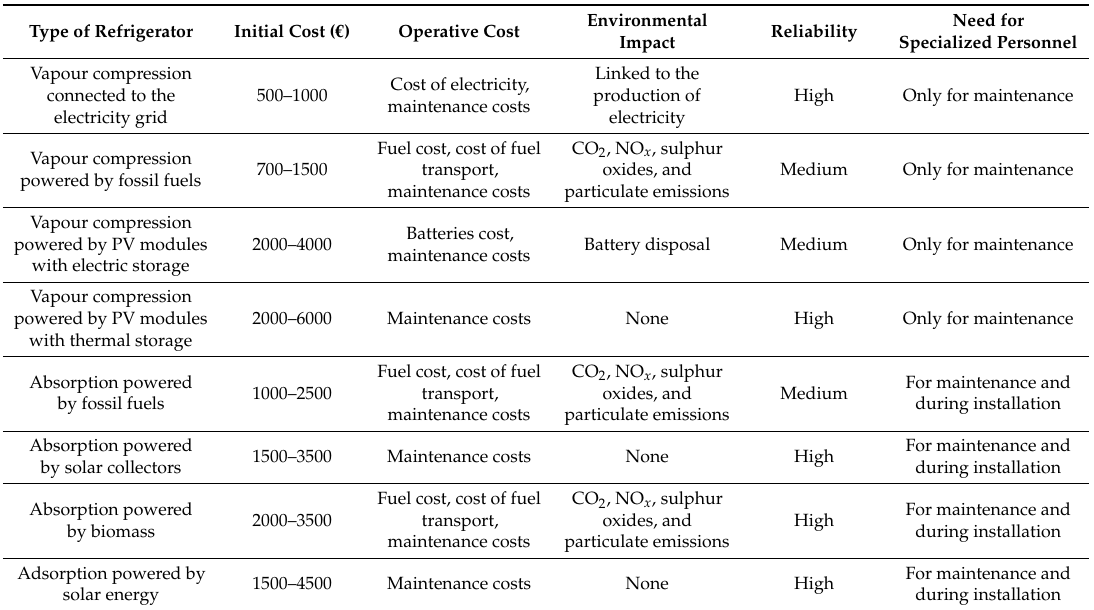
Table 1. Comparison of the main technologies used for food refrigeration in developing countries. PV: